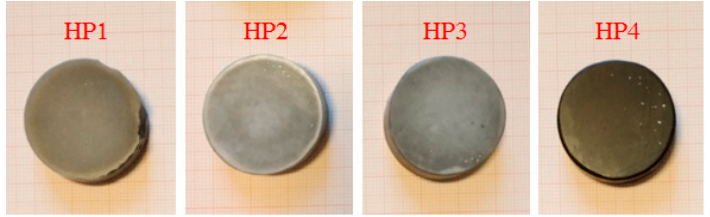
Figure 1. Sintered specimens: HP1—30 min-activated sample, HP2—nonactivated sample, HP3—30 min-activated sample with yttrium addition, and HP4—30 min-activated sample with graphene addition.